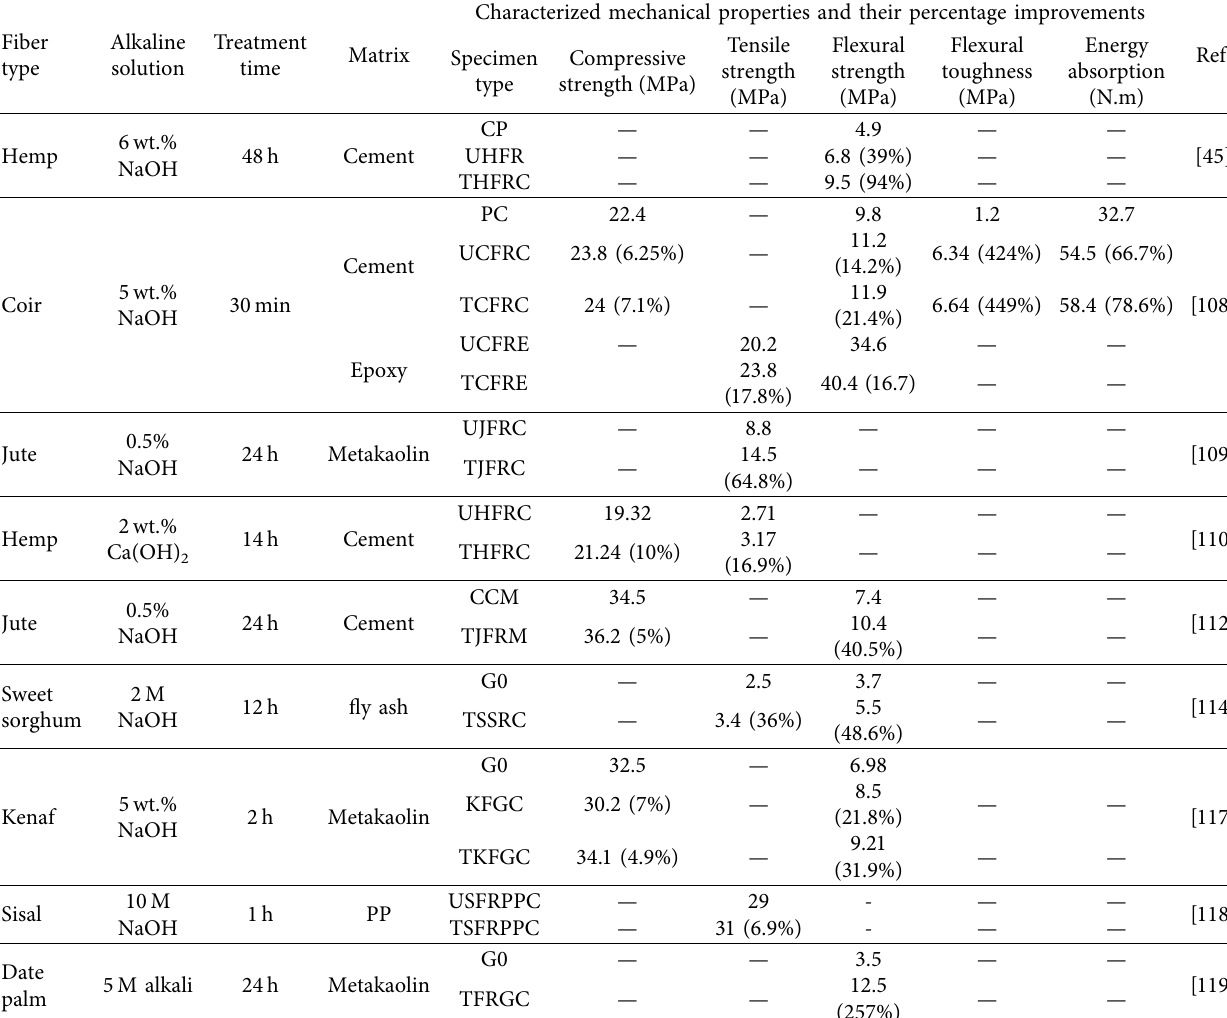
Table 1: Effect of alkaline treatment of fibers on mechanical properties of composites.